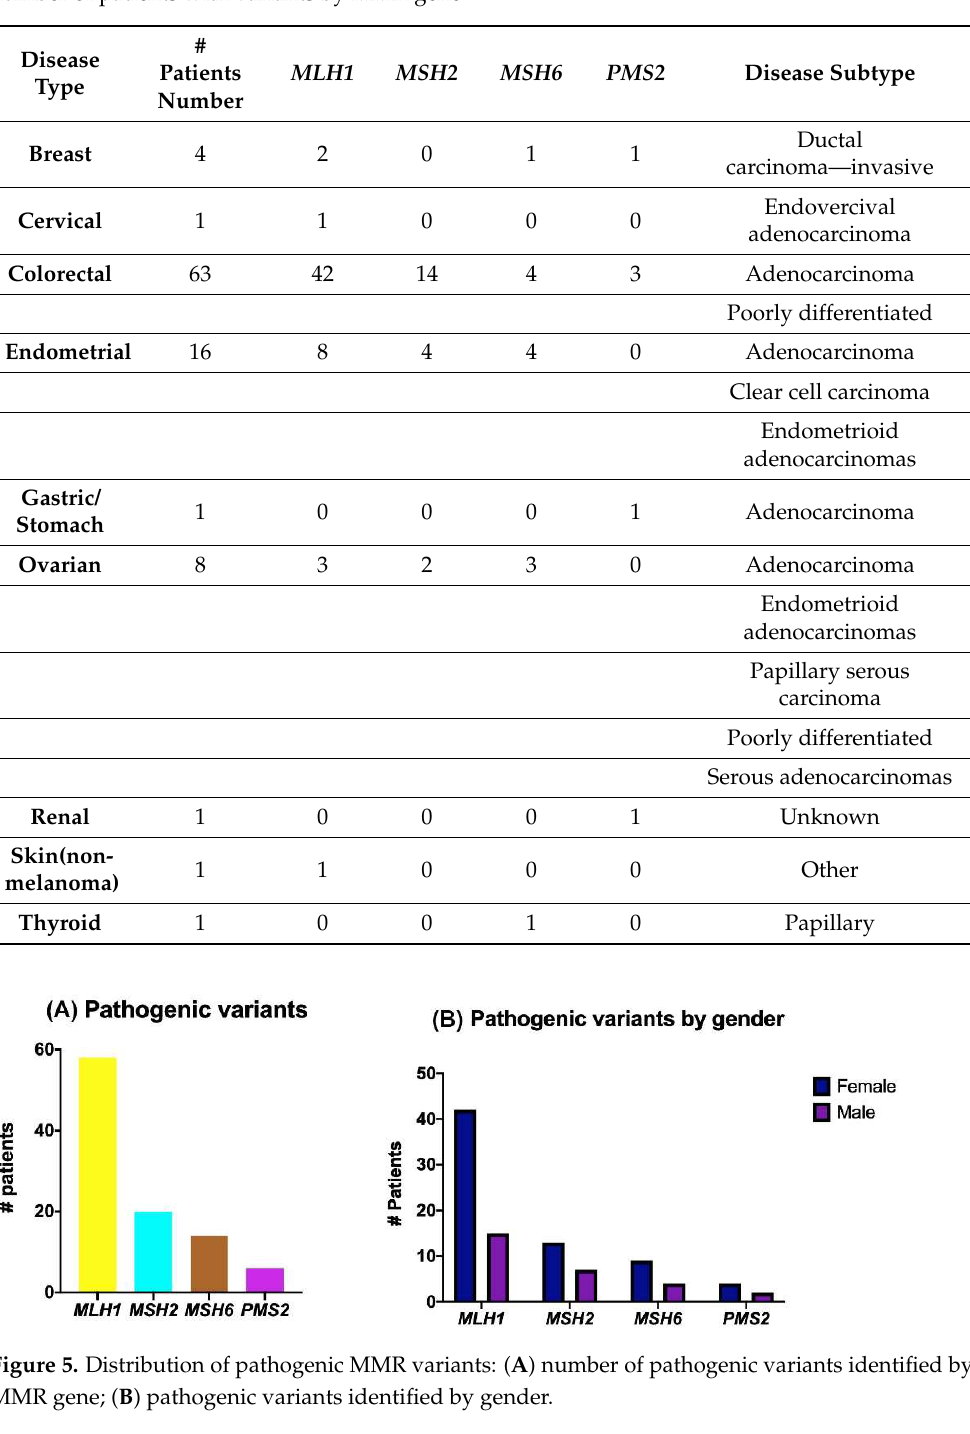
Figure 6. Type of pathogenic variants identified in the cohort of patients carrying a pathogenic var- iant. The number of variants identified for each type of mutation is indicated inside the bars. The most represented type of PV in the cohort was nonsense mutations, in 31.63% of cases, followed by frameshift deletions (17.35%), frameshift duplications (14.29%), whole